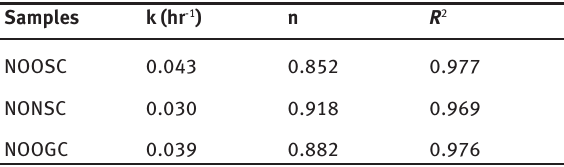
Figure 10: In vitro release of atrazine and atrazine-loaded N -octyl chitosan derivatives micelles in PBS solution at room temperature. Values represent mean of three replicates ± standard deviation. Table 3: Parameters of Korsmeyer-Peppas kinetic model for in vitro controlled release of atrazine-loaded N -octyl chitosan micelles in PBS solution at room temperature and pH